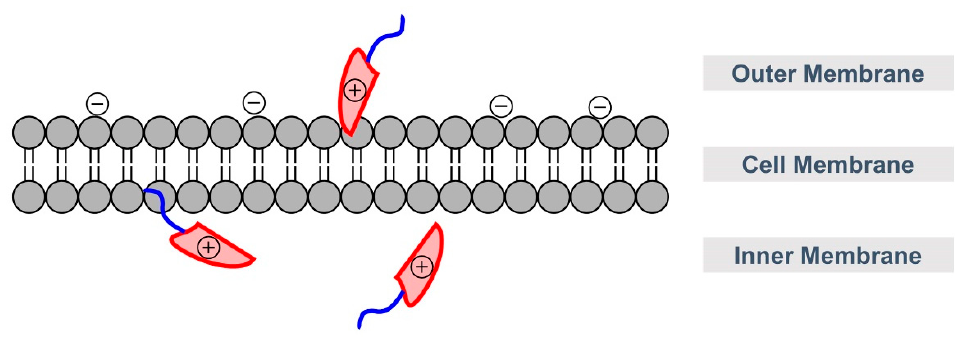
Figure 6. CPP (polycation, in red) passing through cell membrane (negatively charged), carrying its cargo (in blue). Color image available online.